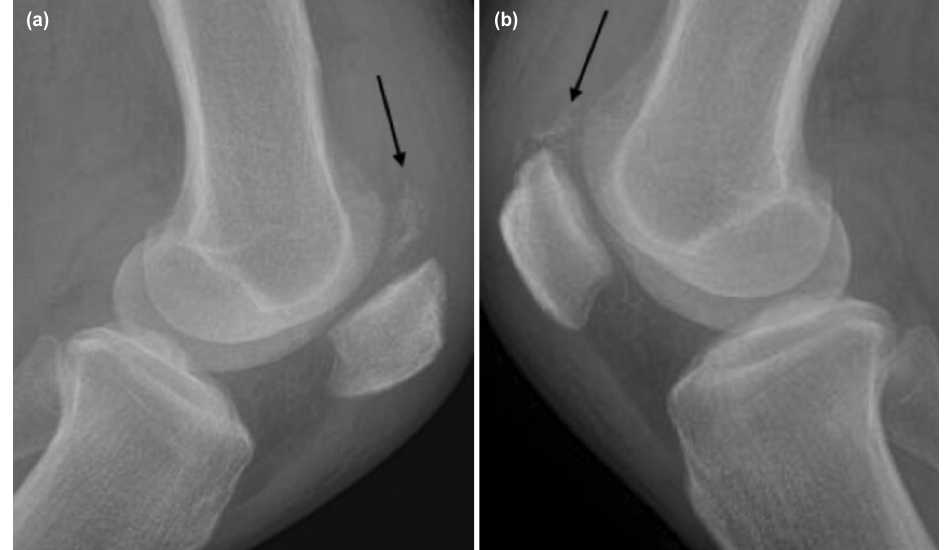
Lateral plain radiograph of the knee shows calcification (arrow) at the quadricep tendon insertion with patella baha, (a) right Fig. 1: knee, (b) left knee.